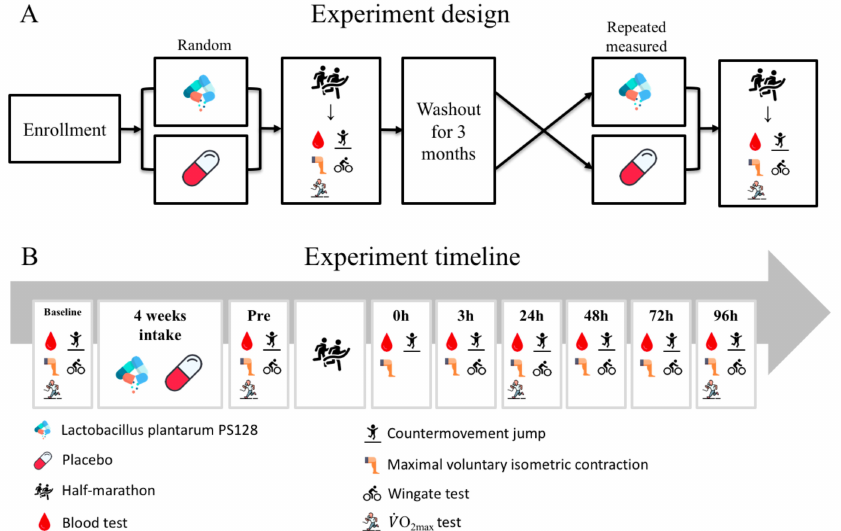
Figure 1. Experimental design flowchart. Experiment design ( A ): A double-blind, randomized, placebo-controlled, counterbalanced, crossover trial was used for the experiment. The period of nutritional supplementation was 4 weeks. Half-marathon (HM) was conducted at the end of the 4-week nutritional supplementation. Participants took 2 capsules of Lactobacillus plantarum PS128 (PS128) each morning and evening before meals for 4 weeks as the PS128 treatment (LT, n = 8), or they took 2 capsules of placebo for 4 weeks as the placebo treatment (PT, n = 8) in the control. After HM, an exercise capacity test, a blood test, and a 3-month washout period were conducted. Then, the two treatments were exchanged, and subsequent interventions and detection were